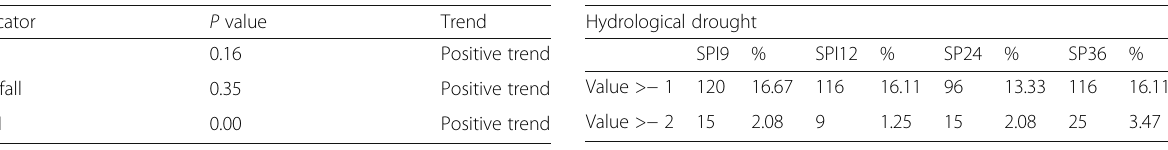
Table 5 Distribution of Hydrological drought events from